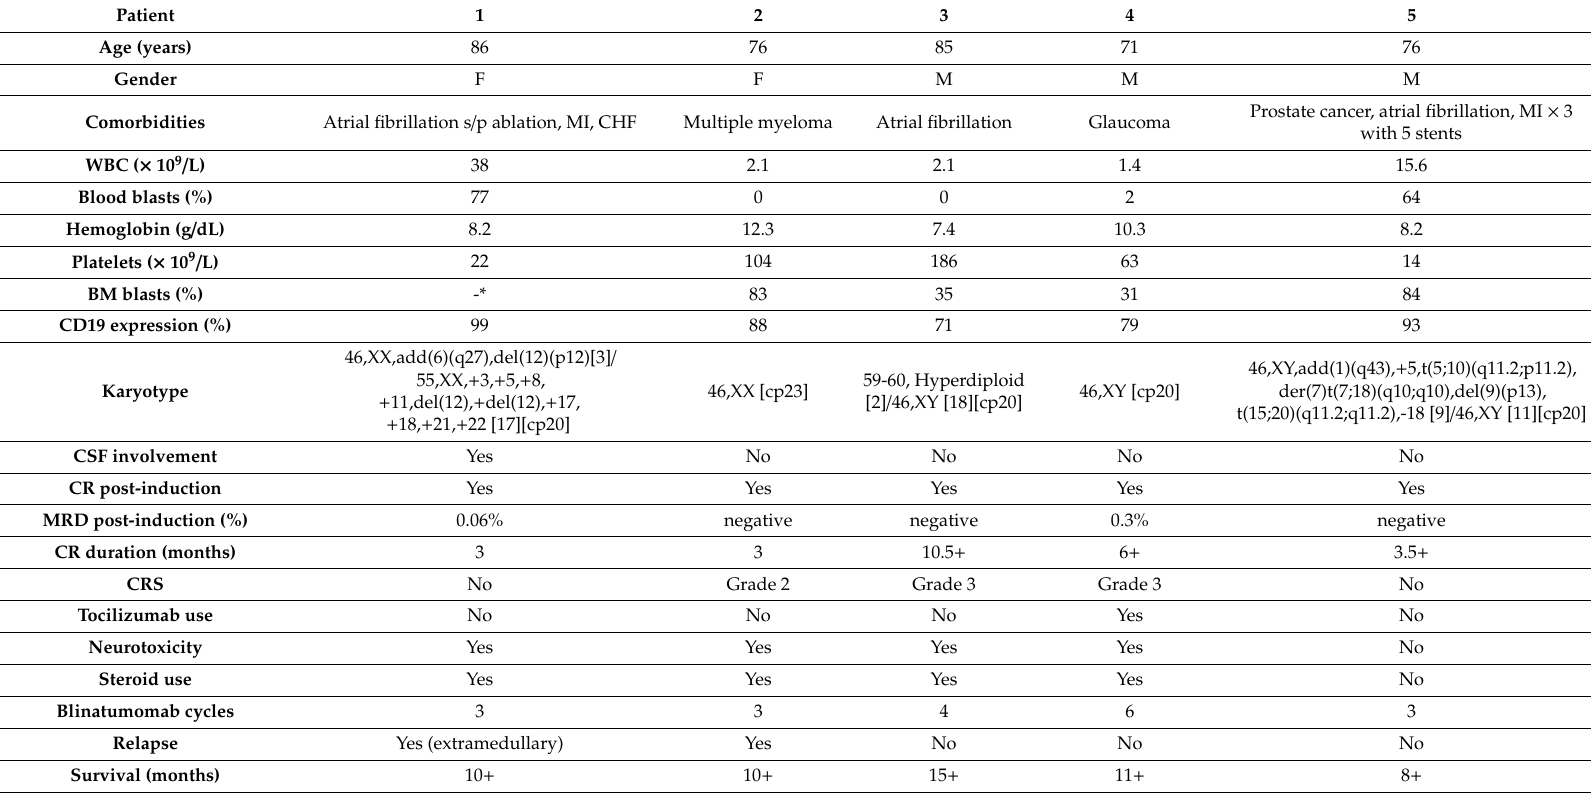
Table 1. Patient and Disease